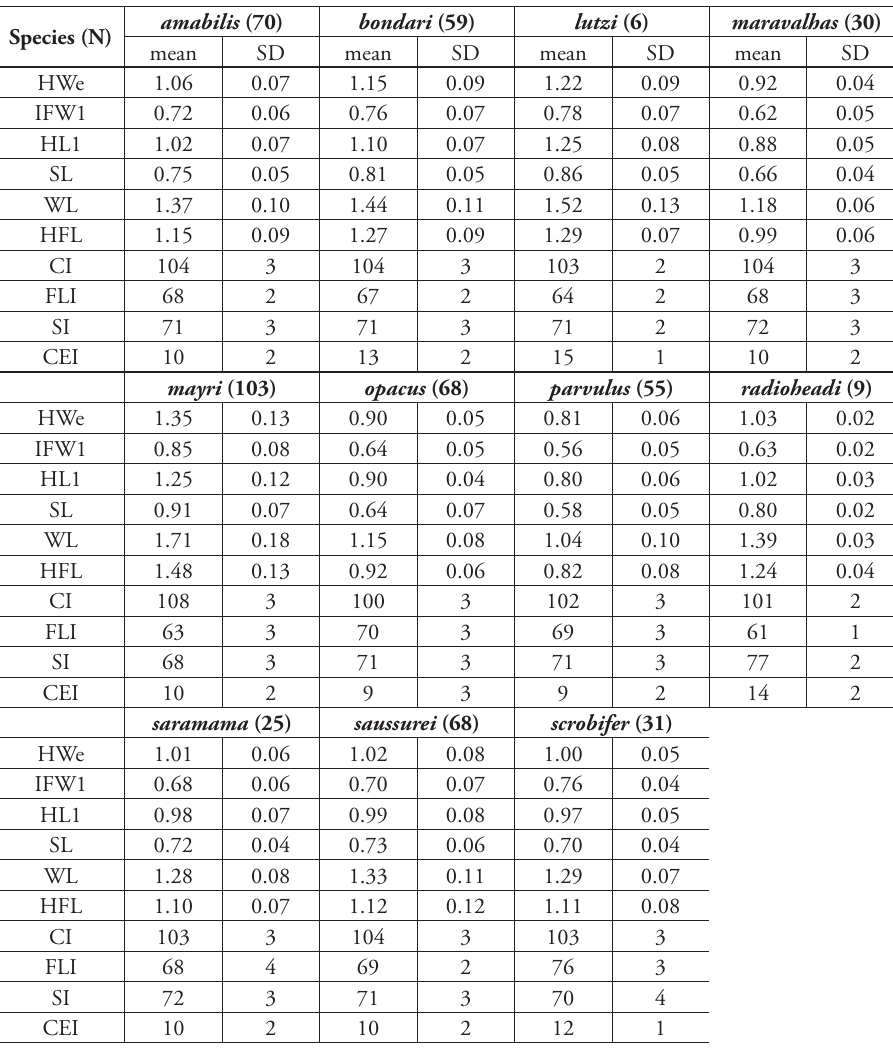
Table 1. Morphological measurements. Mean and standard deviation (SD) values for selected morpho- logical measurements and indices for the Sericomyrmex species . All measurement values are in millimeters. N represents the number of workers measured for each species. The full statistics for all of the morphologi- cal measurements can be found in Suppl. material 2: Table